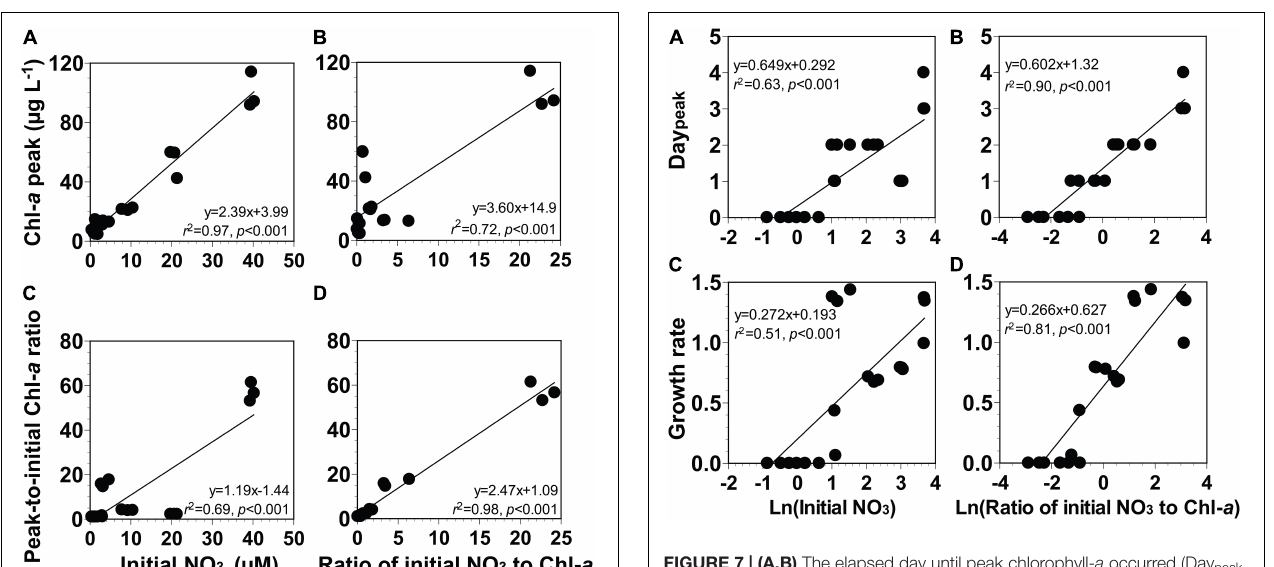
FIGURE 7 | (A,B) The elapsed day until peak chlorophyll- a occurred (Day peak , day) or (C,D) growth rate of the phytoplankton community (day − 1 ) as a function of the natural log of the initial NO 3 (Ln µ M) or the natural log of the ratio of the initial NO 3 to Chl- a [Ln µ M ( µ g L − 1 ) − 1 ]. Data were obtained from the seven experiments incubating seawater collected from St. Gukdong and St. Gyedong in 2019. TABLE 3 | Comparisons of water temperature (T, ◦ C), salinity, NO 3 ( µ M), and initial chlorophyll- a (Chl- a , µ g L − 1 ) in the seawater samples used for the incubation experiments (St. Gukdong and St. Gyedong) and the data obtained from the monitoring sites (St. Gwangyang and St. Masan) in the selected periods between 2016 and 2019 in the South Sea of